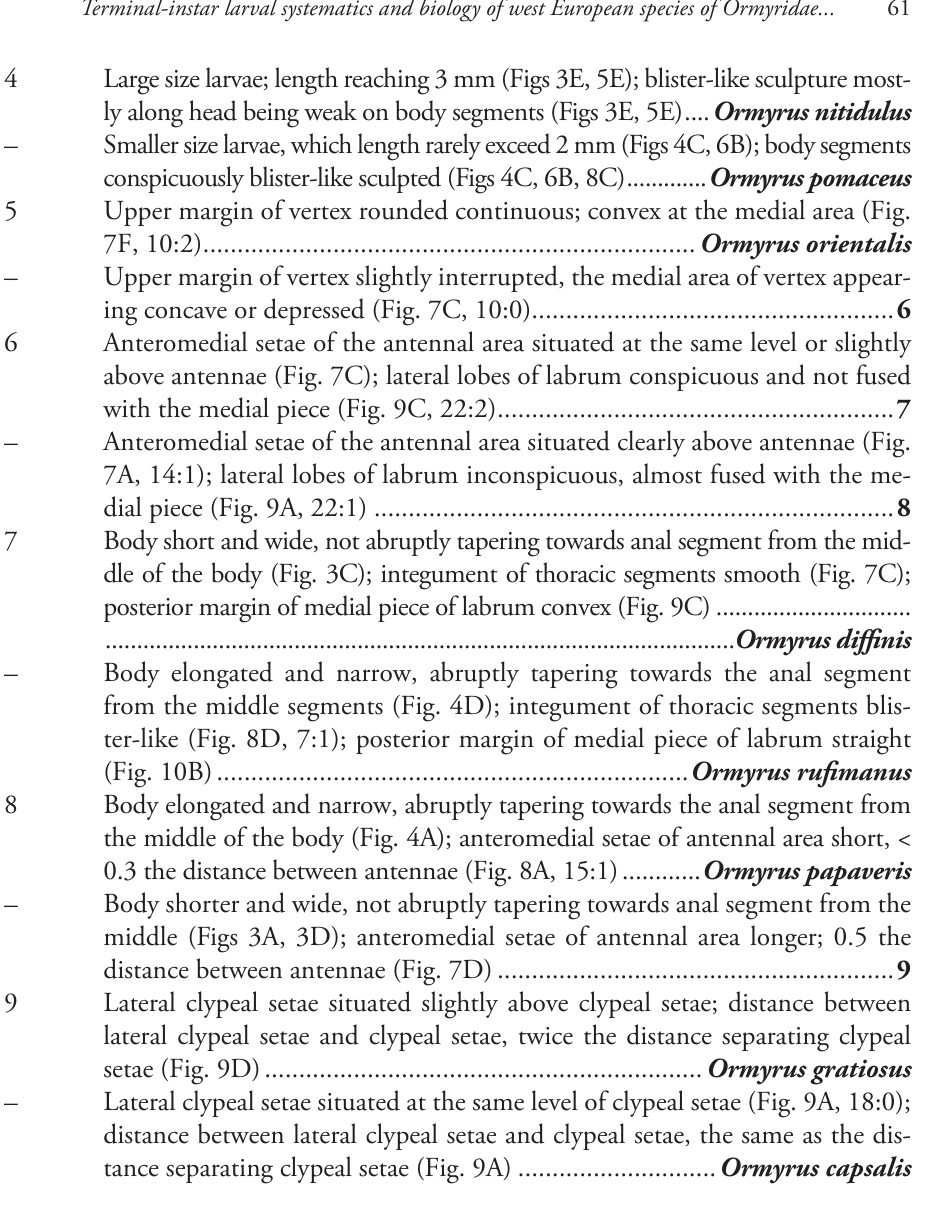
Large size larvae; length reaching 3 mm (Figs 3E, 5E); blister-like sculpture most- ly along head being weak on body segments (Figs 3E, 5E) .... Ormyrus nitidulus – Smaller size larvae, which length rarely exceed 2 mm (Figs 4C, 6B); body segments conspicuously blister-like sculpted (Figs 4C, 6B, 8C) ............. Ormyrus pomaceus 5 Upper margin of vertex rounded continuous; convex at the medial area (Fig. 7F, 10:2) ........................................................................ Ormyrus orientalis – Upper margin of vertex slightly interrupted, the medial area of vertex appear- ing concave or depressed (Fig. 7C, 10:0)..................................................... 6 6 Anteromedial setae of the antennal area situated at the same level or slightly above antennae (Fig. 7C); lateral lobes of labrum conspicuous and not fused with the medial piece (Fig. 9C, 22:2) .......................................................... 7 – Anteromedial setae of the antennal area situated clearly above antennae (Fig. 7A, 14:1); lateral lobes of labrum inconspicuous, almost fused with the me- dial piece (Fig. 9A, 22:1) ............................................................................ 8 7 Body short and wide, not abruptly tapering towards anal segment from the mid- dle of the body (Fig. 3C); integument of thoracic segments smooth (Fig. 7C); posterior margin of medial piece of labrum convex (Fig. 9C) ............................... .................................................................................................... Ormyrus diffinis – Body elongated and narrow, abruptly tapering towards the anal segment from the middle segments (Fig. 4D); integument of thoracic segments blis- ter-like (Fig. 8D, 7:1); posterior margin of medial piece of labrum straight (Fig. 10B) ..................................................................... Ormyrus rufimanus 8 Body elongated and narrow, abruptly tapering towards the anal segment from the middle of the body (Fig. 4A); anteromedial setae of antennal area short, < 0.3 the distance between antennae (Fig. 8A, 15:1) ............ Ormyrus papaveris – Body shorter and wide, not abruptly tapering towards anal segment from the middle (Figs 3A, 3D); anteromedial setae of antennal area longer; 0.5 the distance between antennae (Fig. 7D) .......................................................... 9 9 Lateral clypeal setae situated slightly above clypeal setae; distance between lateral clypeal setae and clypeal setae, twice the distance separating clypeal setae (Fig. 9D) ................................................................ Ormyrus gratiosus – Lateral clypeal setae situated at the same level of clypeal setae (Fig. 9A, 18:0); distance between lateral clypeal setae and clypeal setae, the same as the dis- tance separating clypeal setae (Fig. 9A) ............................. Ormyrus capsalis